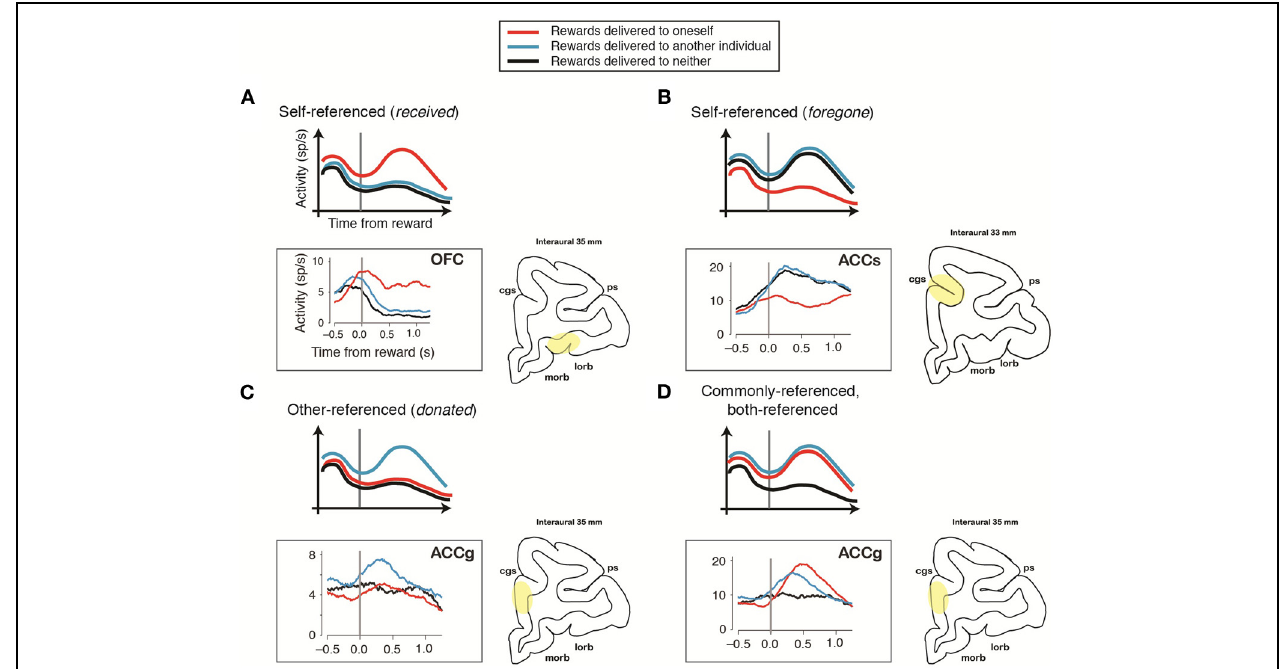
FIGURE 2 | Schematic and empirical examples of reward outcomes represented in different frames of reference during social interactions. Illustrative peri-stimulus time histograms (PSTHs) (top of each panel) show the activity of an individual reward-sensitive neuron aligned to the time of reward. The PSTHs displayed on the bottom of each panel (in the gray box) show the activity of a single neuron recorded from different regions of the primate frontal cortex during a social reward-allocation task [modified with permission from Chang et al. (2013)] that corresponds to the illustrative PSTHs above. The brain region from which each neuron was recorded is highlighted on the right (in yellow). cgs, cingulate sulcus; lorb, lateral